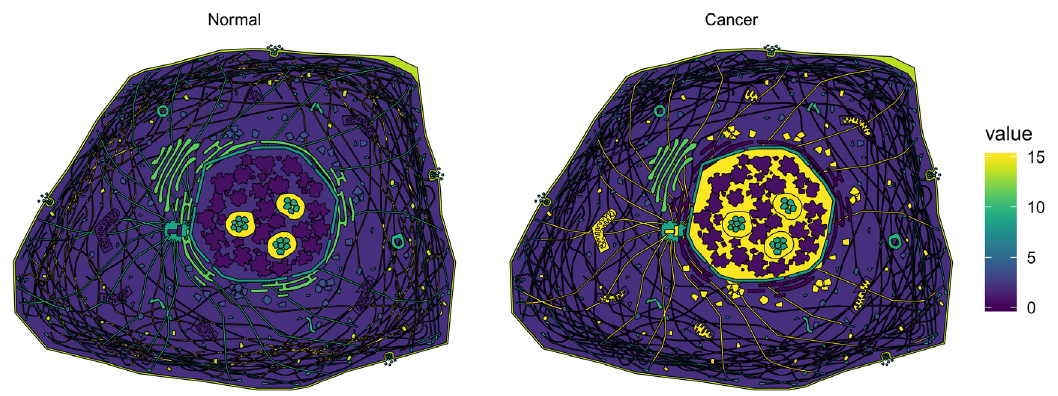
Figure 6. Cell diagram to plot values at specific cellular